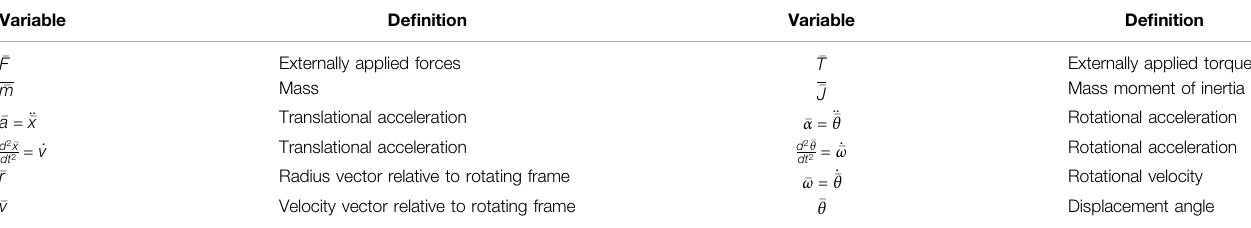
TABLE 5 | Proximal variable de fi